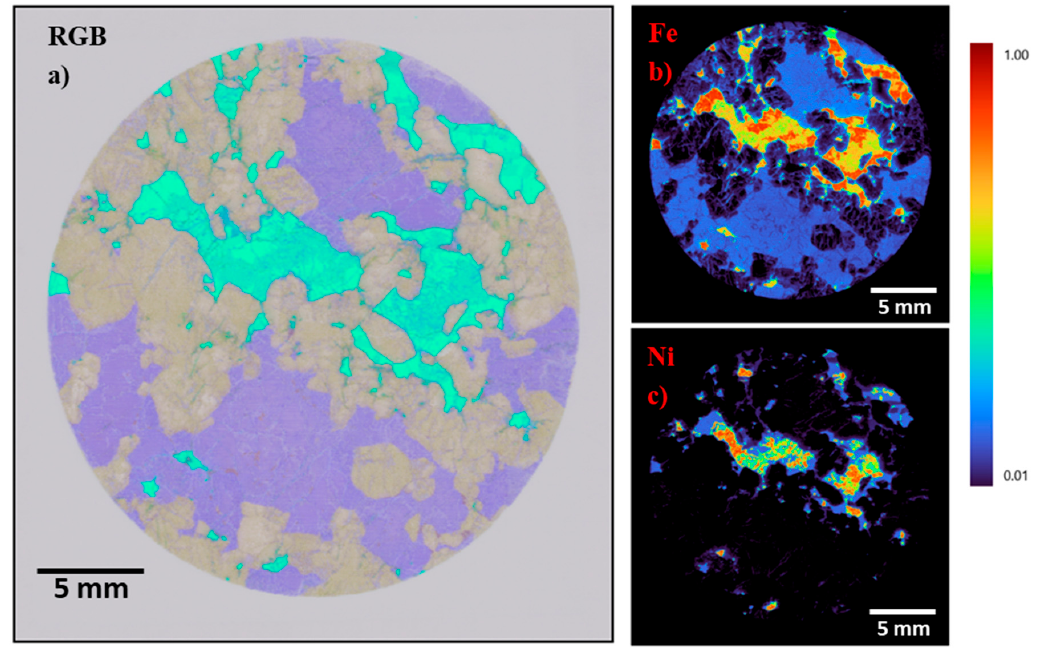
Figure 4. ( a ) RGB unsupervised PCA LIBS image presenting three major mineral groups (grey: plagioclase, purple: pyroxene, and cyan: sulfides for PGE1a sample); The corresponding elemental heat maps in ( b ) and ( c ) highlight the distribution of Fe (sulfides) and Ni (pentlandite), respectively. Likewise, in the BSE images generated by SEM (data not shown), similar grayscale luminosities were assigned to minerals of the same or similar elemental composition. An important difference between mineral phases assignation using the LIBS PCA pre-imaging and using the SEM BSE pre- imaging is that the PCA is a pre-image of the same identified spectra, while the BSE image has a higher resolution image than the dot mapping EDS data matrix.